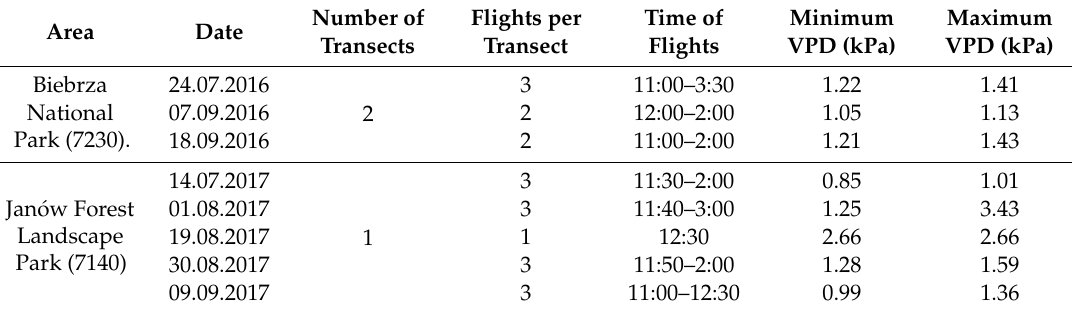
Table 1. Acquisition dates and time, the number of transects, flights per transect, and vapor pressure deficit (VPD) values during flights for both research